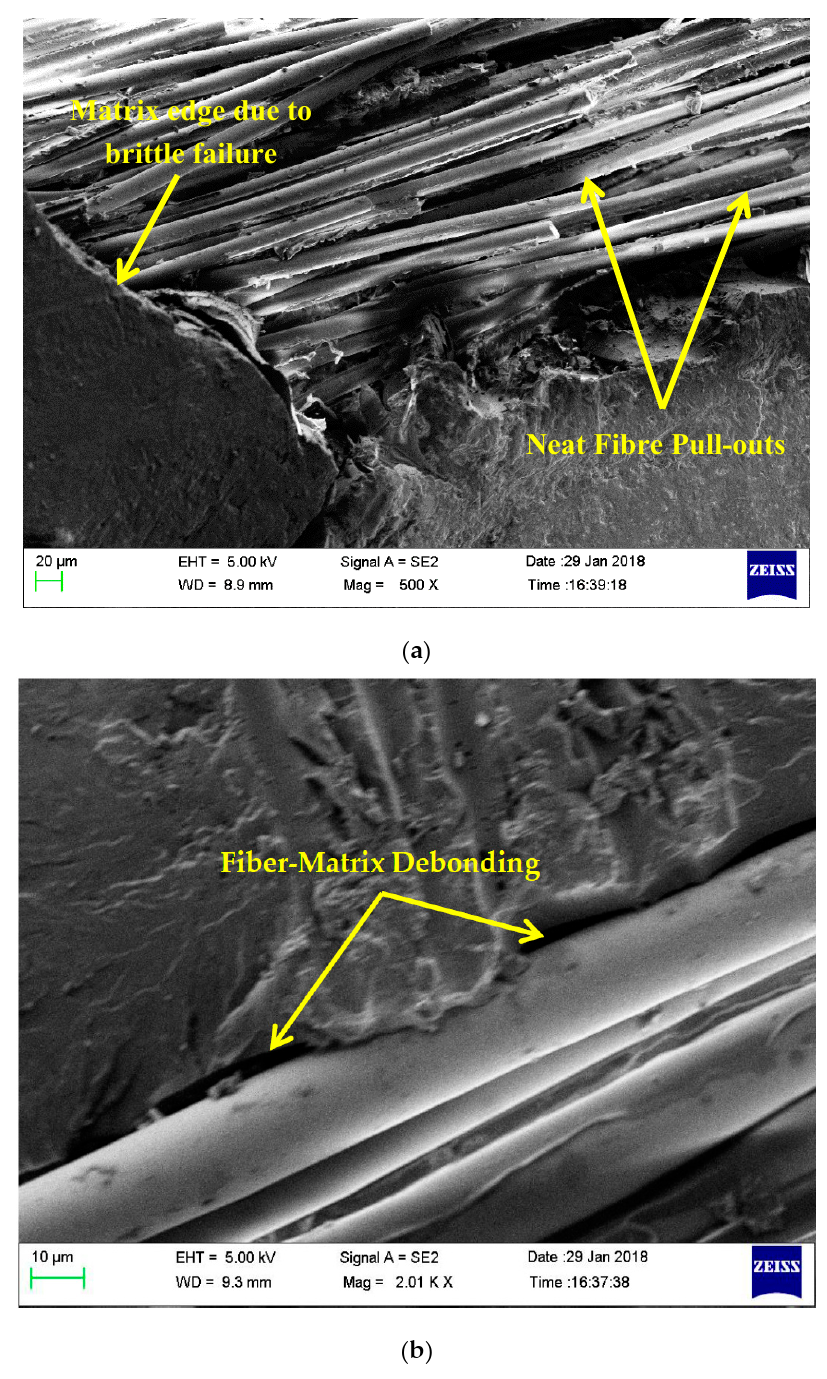
Figure 7. Failure analysis of pristine composites ( a ) Fibre pulled out neatly without fracture and damage ( b ) Poor interfacial bonding between matrix and fibre.